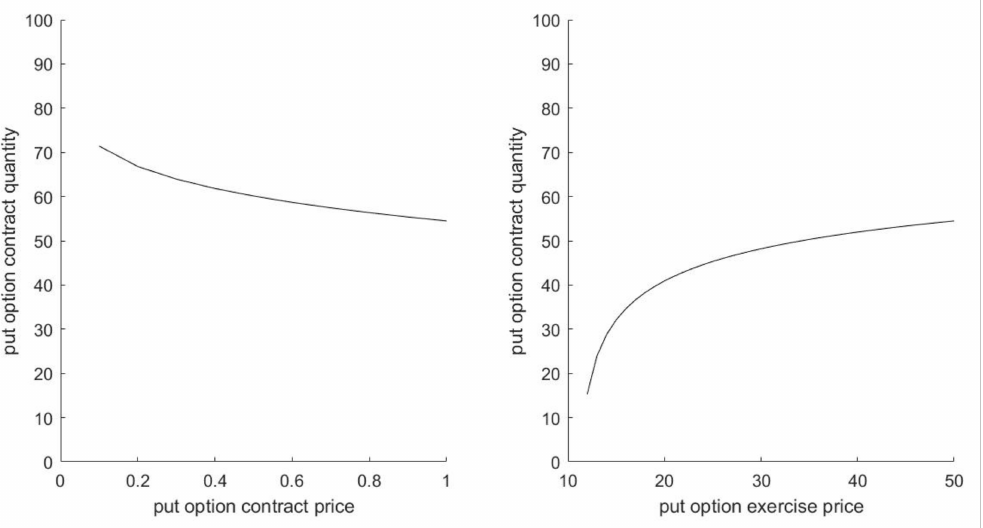
Figure 4. Sensitive to put option contract